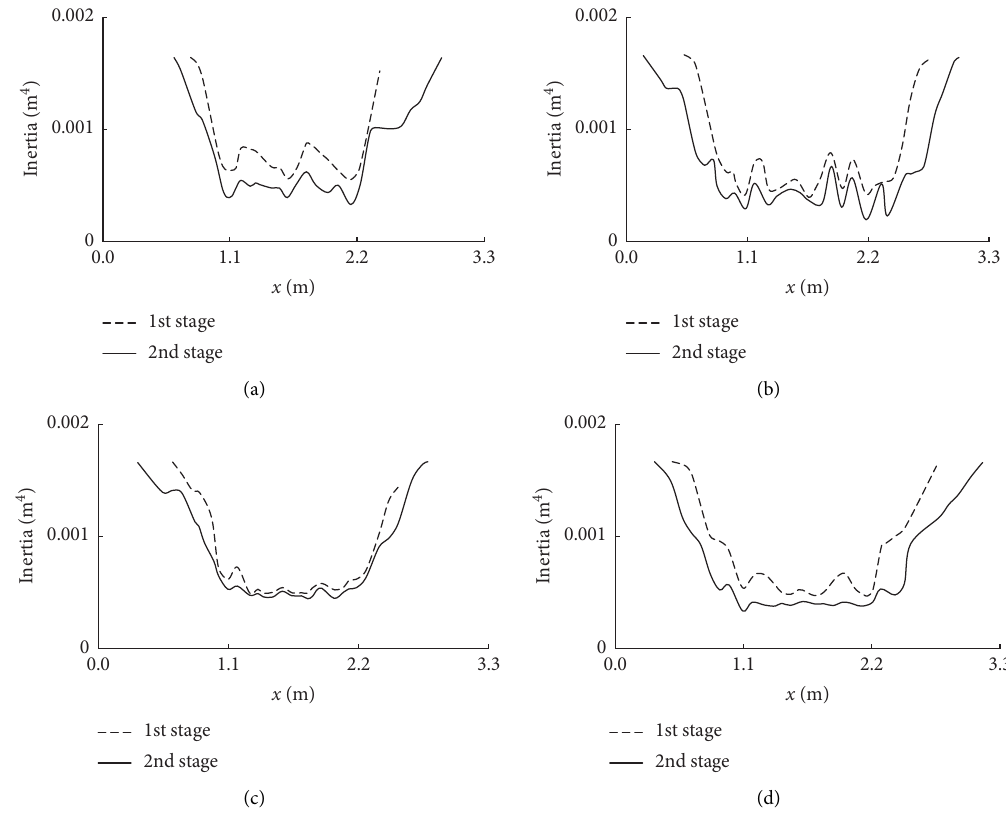
Figure 7: Inertias of key sections in the effect regions for the beams (a) B2, (b) B3, (c) B5, and (d)